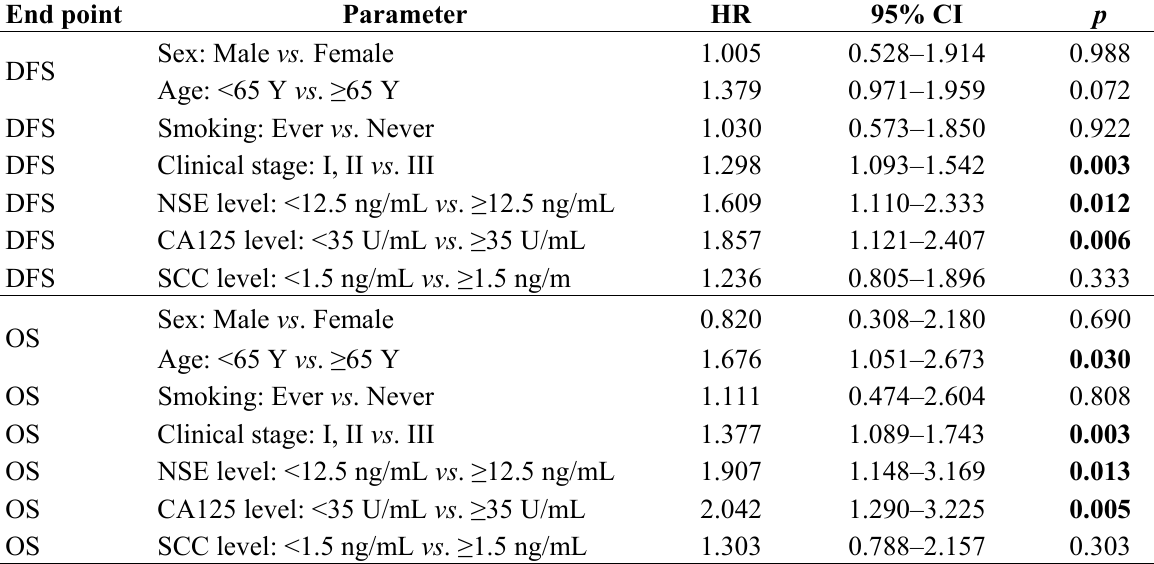
Table 2. Multivariate analysis for disease free survival (DFS) and overall survival (OS) for all